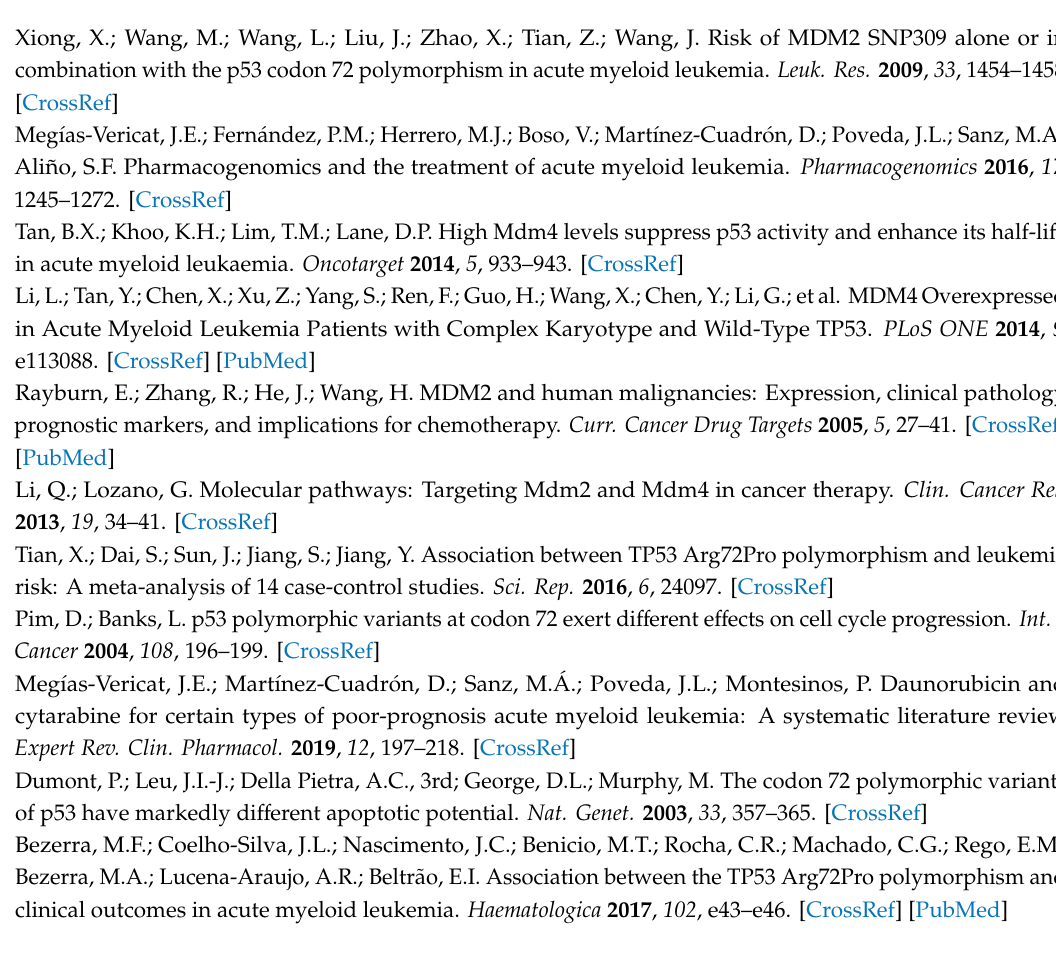
Table S1: Associations between demographic and clinical features and TP53 rs1042522 variant in codominant, dominant and recessive models, Table S2: Associations between demographic and clinical features and MDM2 rs2279744 variant in codominant, dominant and recessive models, Table S3: Associations between demographic and clinical features and MDM2 rs3730485 variant in codominant, dominant and recessive models, Table S4: Associations between demographic and clinical features and MDM4 rs4245739 variant in codominant, dominant and recessive models. The data used in the current study may be available upon reasonable